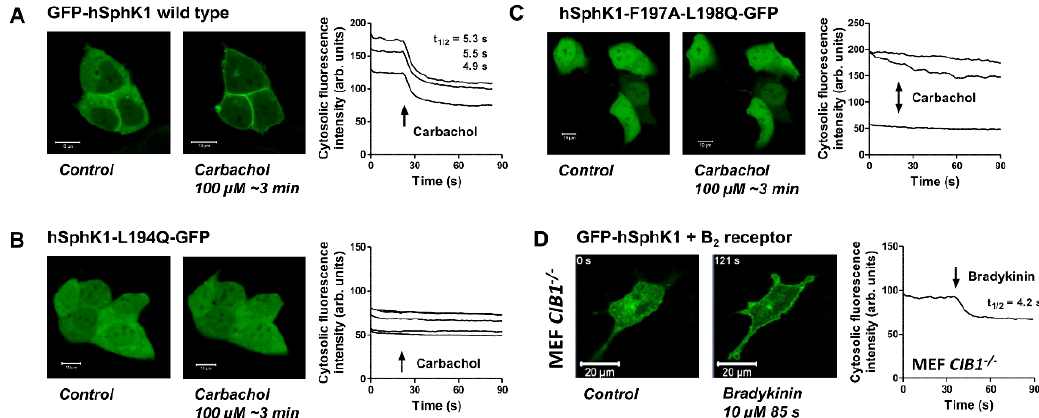
Figure 5. Role of the hydrophobic patch in SphK1 for G q / 11 -mediated SphK1 translocation. ( A – C ) HEK-293 cells stably expressing the M 3 receptor were transfected with GFP-hSphK1, hSphK1-L194Q-GFP, or hSphK1-F197A-L198Q-GFP. Translocation of SphK1 mutants was studied upon stimulation of the cells with 100 µ M carbachol. Shown are images before and after stimulation, and time courses of cytosolic fluorescence from representative experiments. In ( C ), the cytosolic fluorescence of the cell in the upper left could not be evaluated because of the strong change in cell shape. The micrometer bars represent 10 µ m. ( D ) Role of CIB1 for G q -mediated SphK1 translocation. MEFs from CIB1-deficient mice were transfected with GFP-hSphK1 and the B 2 receptor. Shown are images and time courses of cytosolic fluorescence from a representative time series during which 10 µ M bradykinin was added after 35 s. The two images, thus, show localization of GFP-hSphK1 before and 85 s after addition of bradykinin. Micrometer bars, 20 µm.